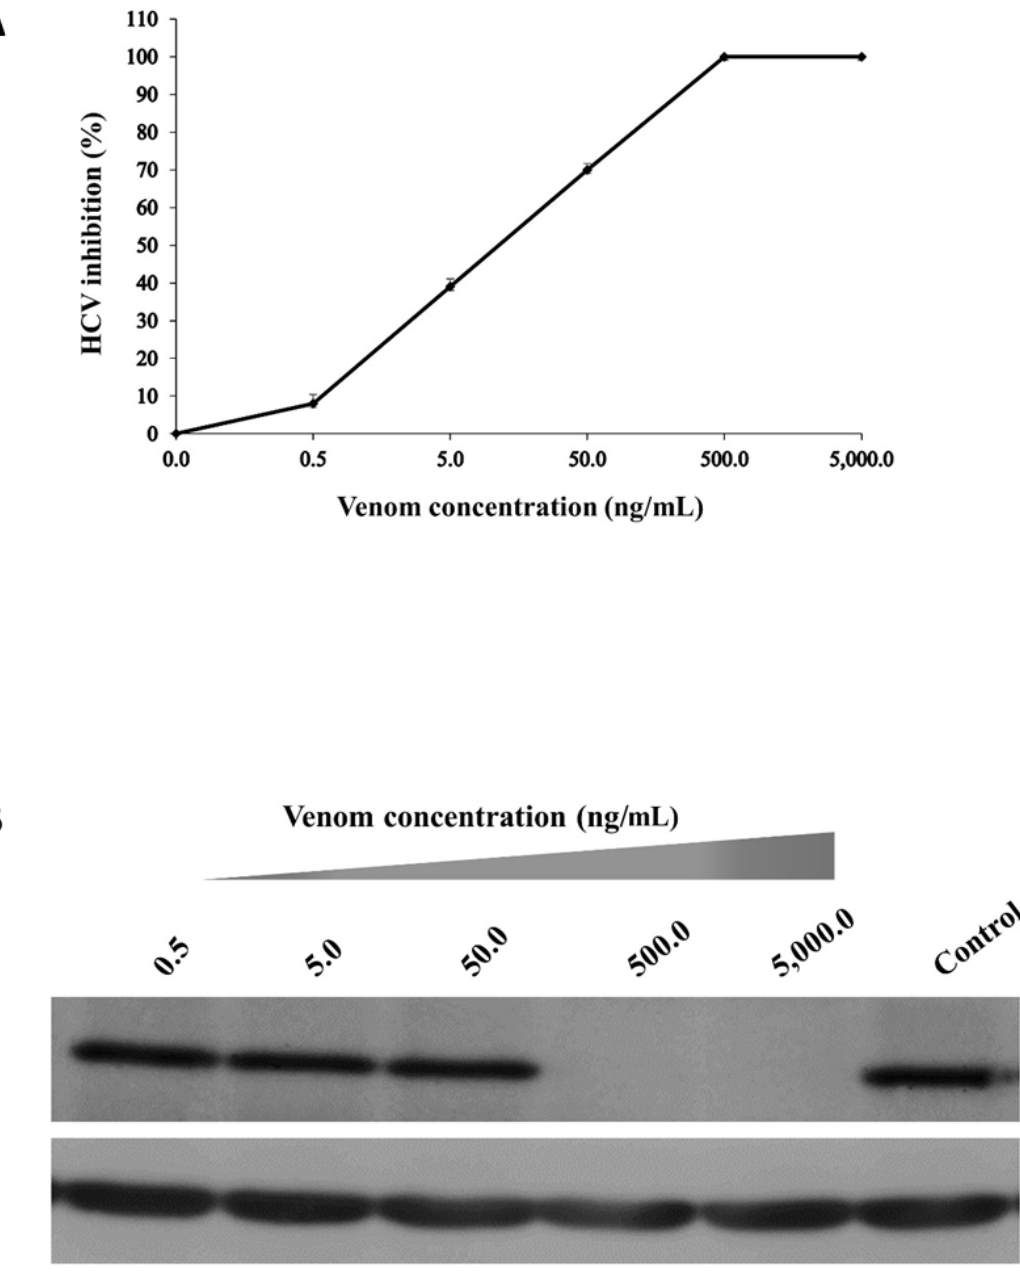
Figure 1. The anti-HCV activity of WV is dose dependent. Serial dilutions of WV were mixed with a fixed amount of HCV and inoculated to Huh7it-1 cells at a multiplicity of infection of 0.5 pfu/cell. The cells were washed and re-incubated in medium containing the same concentrations of WV for 46 h. (A) Amount of HCV infectious particles in the supernatants. The culture supernatants were collected and checked for virus infectivity. Percent of HCV inhibition at different concentrations (0.5 to 5,000 ng/mL) was shown. Data were obtained from two independent experiments and represented as means ± SEM. (B) Accumulation of HCV NS3 protein inside the cells. Virus-infected cells were analyzed by immunoblot using an anti-HCV NS3 antibody. GAPDH was used as an internal control.